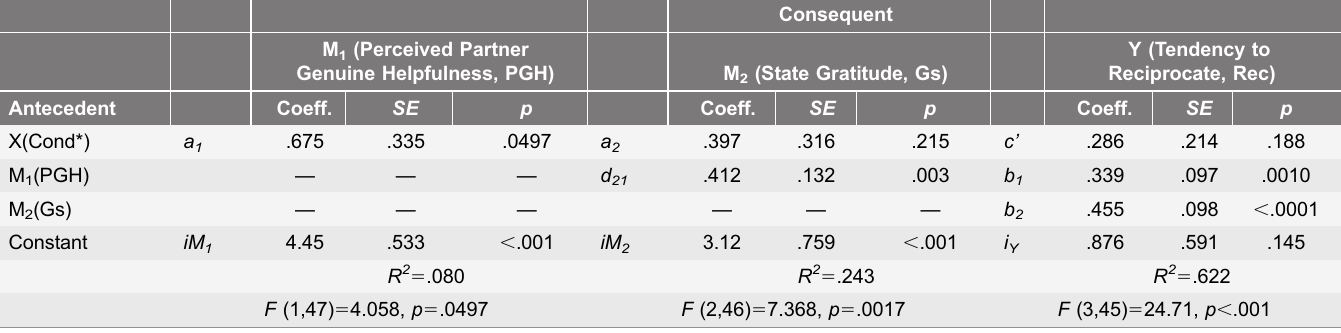
Table 2. Regression Coefficients, Standard Errors, and Model Summary Information for the Donor Intent Perception Serial Multiple Mediator